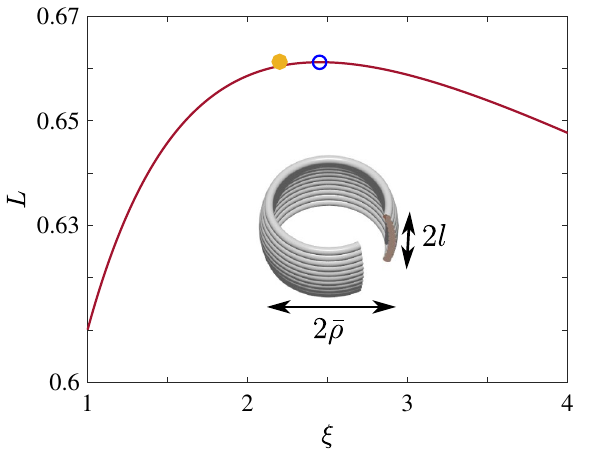
ρ/ l . The open dot labels = ¯ 3 / 2 /( 2 π √ d ) . Inset: